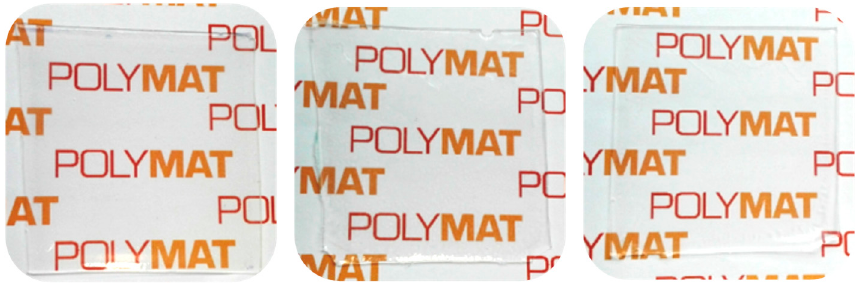
Figure 7. Pictures of polymer films containing (from left to right) 20, 30, or 40 wbm% methacrylate fructose.